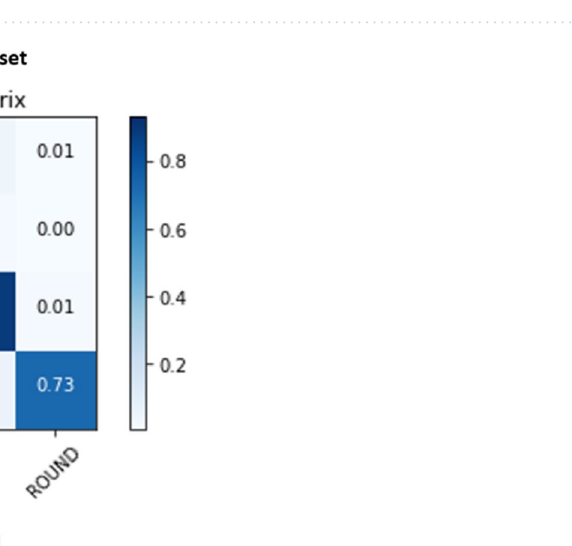
Figure 10. Confusion matrix of the stacked ensemble of models for the BI-RADS category classification on the mammography datasets.